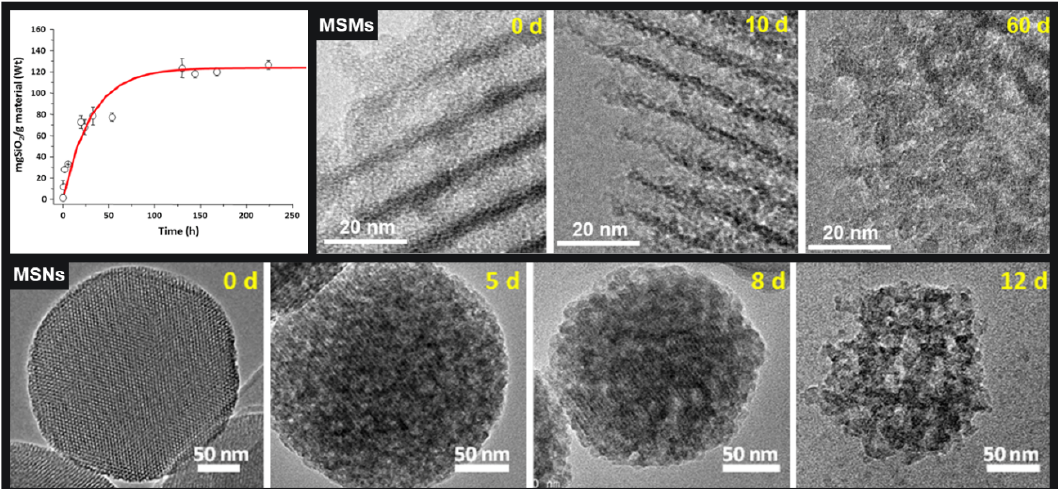
Figure 2. Top left corner: Silica dissolution profile of pure MSMs in physiological medium (Phosphate Buffer Solution, PBS); top right corner: transmission electron microscopy images of the degradation process of MSMs in PBS at different time points; Bottom: transmission electron microscopy images of the degradation of MSNs in PBS at different time points. Adapted with the permission from [51], published by Springer Nature, 2017.